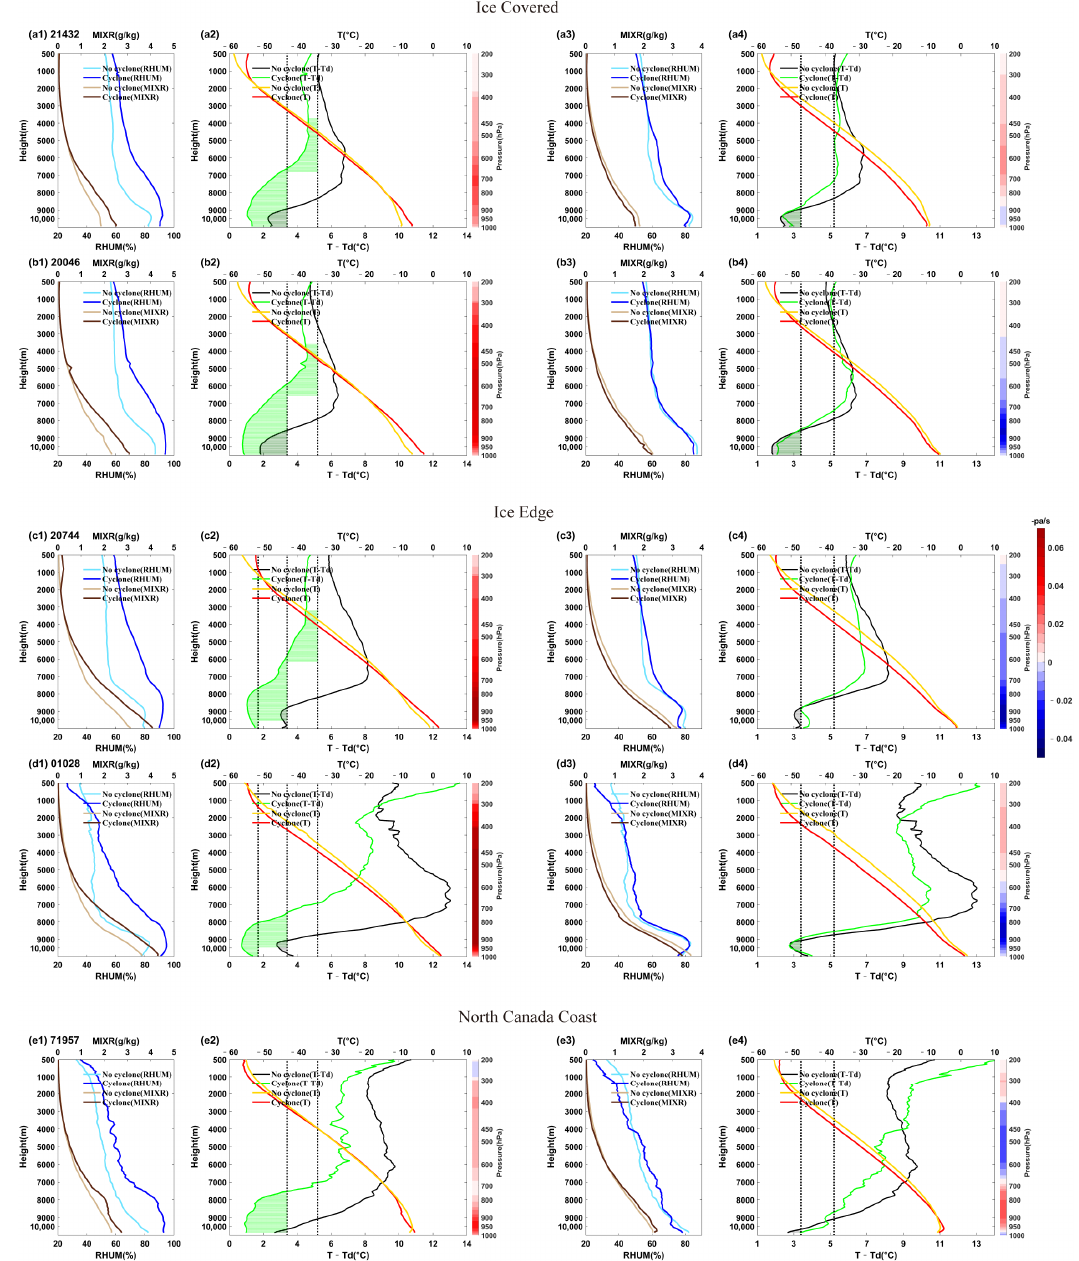
Figure 10. Composited vertical pro fi les of air temperature on no-cyclone days (yellow line) and cyclone days (red line), the mixing ratio on no-cyclone days (light brown line) and cyclone days (dark brown line), the relative humidity on no-cyclone days (light blue line) and cyclone days (dark blue line), and the dew point de fi cit on no-cyclone days (black line) and cyclone days (green line) based on the relative humidity increase days ( a1 – e1 , a2 – e2 ) and relative humidity decrease days ( a3 – e3 , a4 – e4 ) at the fi ve sounding stations. ( a1 – e1 / a3 – e3 ) illustrate the under 10,000 m pro fi les of the air temperature and relative humidity on the relative increase cyclone days/relative decrease cyclone days versus no-cyclone days. ( a2 – e2 / a4 – e4 ) illustrate the under 10,000 m pro fi les of the air temperature and dew point de fi cit on the relative increase cyclone days/relative decrease cyclone days versus no-cyclone days, in which the dew point de fi cit under the conditions of air temperature (vertical black do tt ed lines) decides whether the cloud formation criterion is met. The vertical location where the cloud formation criterion is met is shown as the black and green hatched areas on the no-cyclone days and cyclone days, respectively.